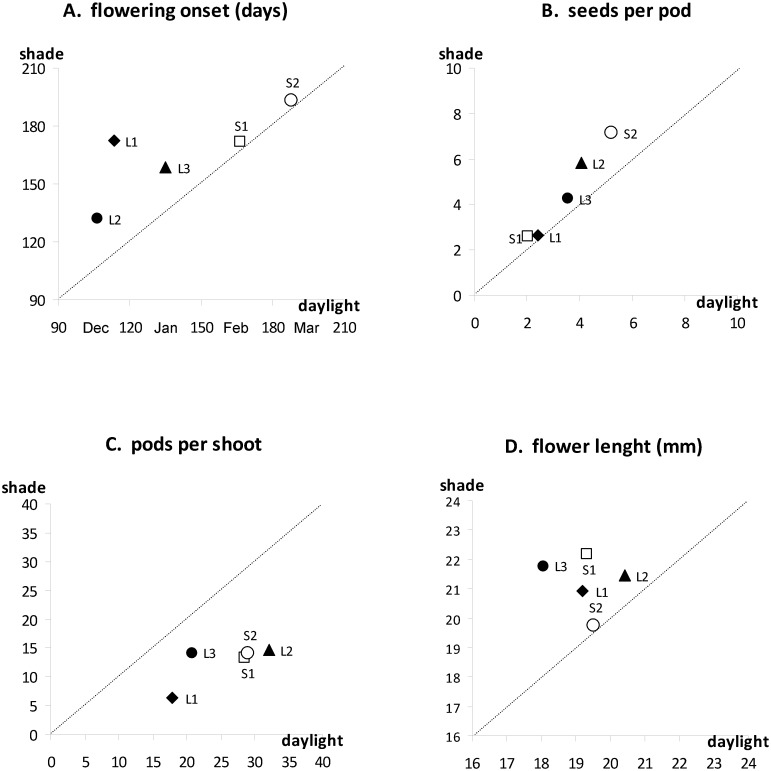
Relation between trait means measured on Ulex europaeus in full daylight and in the shade—reproductive traits.Each point represents the average of the values obtained for a given genotype for all years of measurement (4 years for A, B, C, one year for D). Dotted line: X = Y (equal values in daylight and shade).